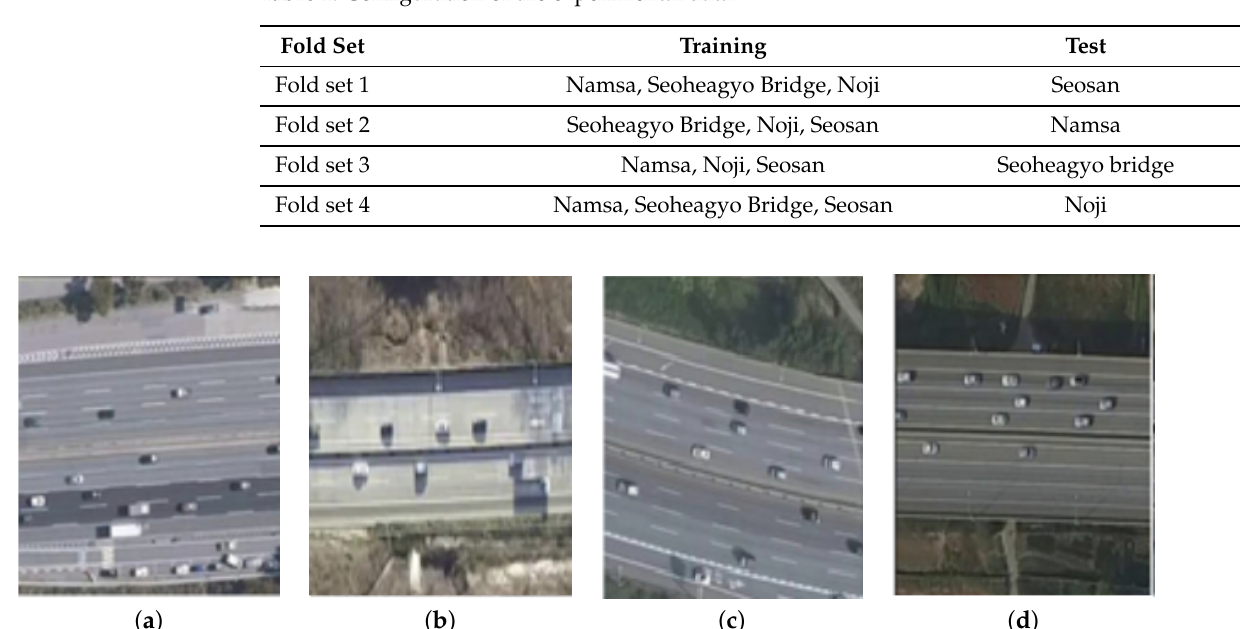
Table 1. Configuration of the experimental data.